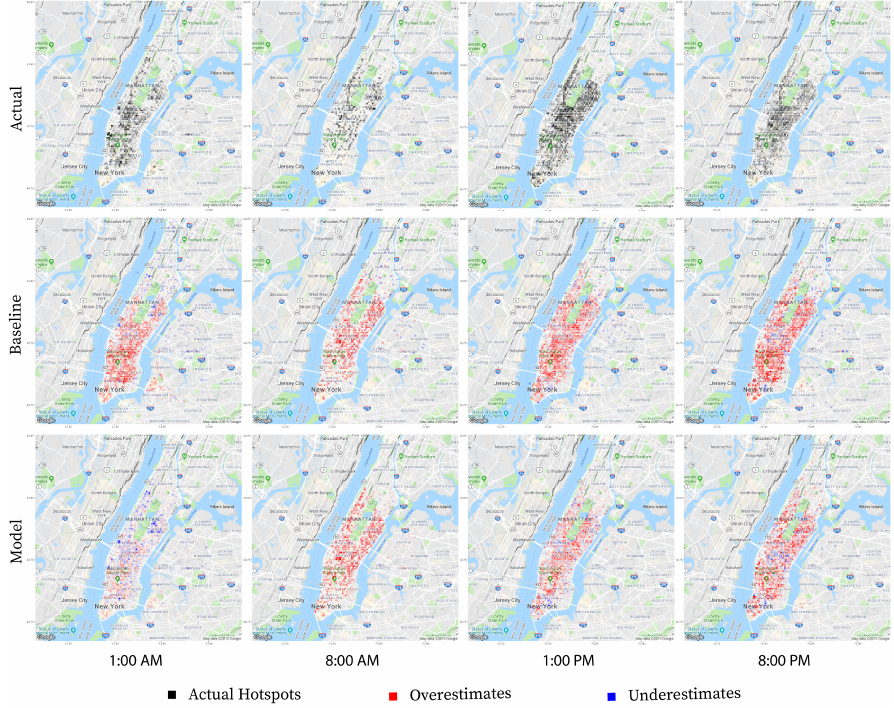
Figure 6. A comparison between the baseline prediction, 4-holiday Random Forest model prediction, and actual result for next day prediction of Christmas day 25 December